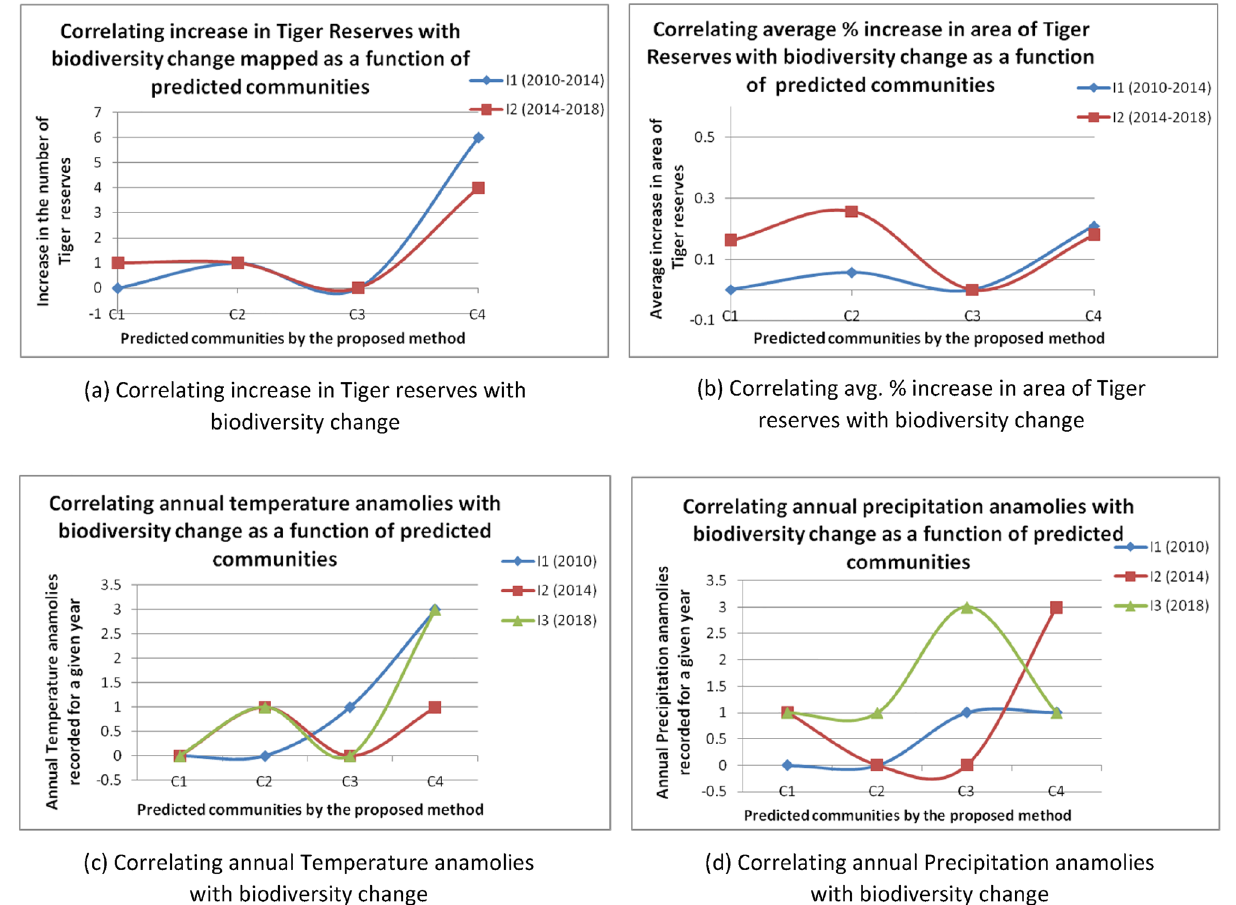
Figure 6. ( a ) and ( b ) Correlating land-use conversion with biodiversity change as a function of four communities predicted by QICD for intervals I 1 (2010–2014) and I 2 (2014–2018), ( c ) and ( d ) Correlating climate change with biodiversity change as a function of four communities predicted by QICD for timestamps I 1 (2010), I 2 (2014) and I 3